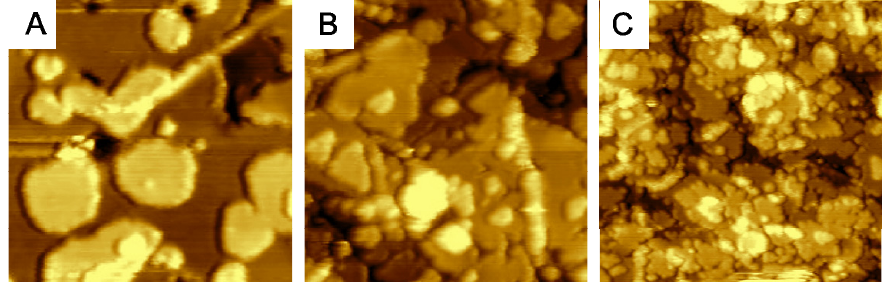
Figure 5. Quantification of morphological features of nanostructured ceria samples